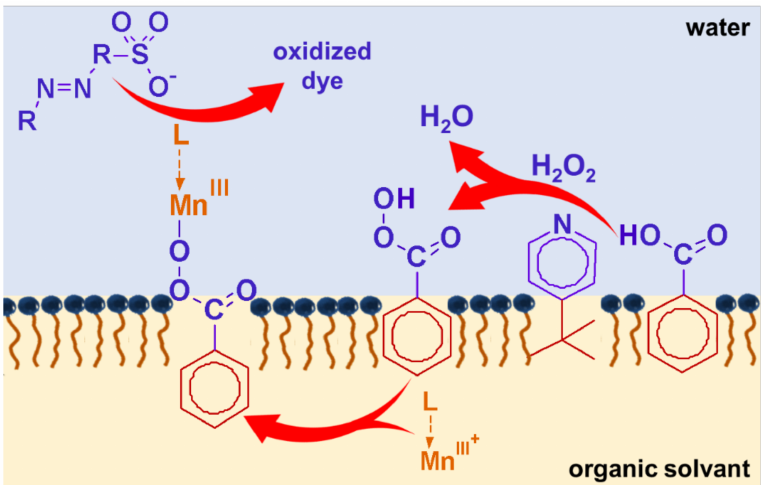
Figure 31. A schematic illustration of a catalytic µ em based on octaethylene glycol monododecyl ether, hexadecane, dichloromethane, and water (blue: hydrophilic atoms; red: hydrophobic atoms; orange: manganese